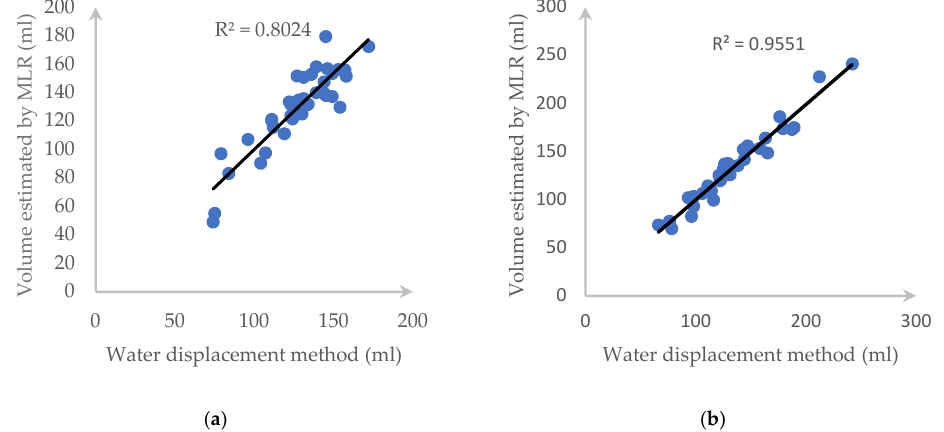
Figure 26. R 2 and correlation between MLR and water displacement method for: ( a ) a carrot and ( b ) a cucumber.